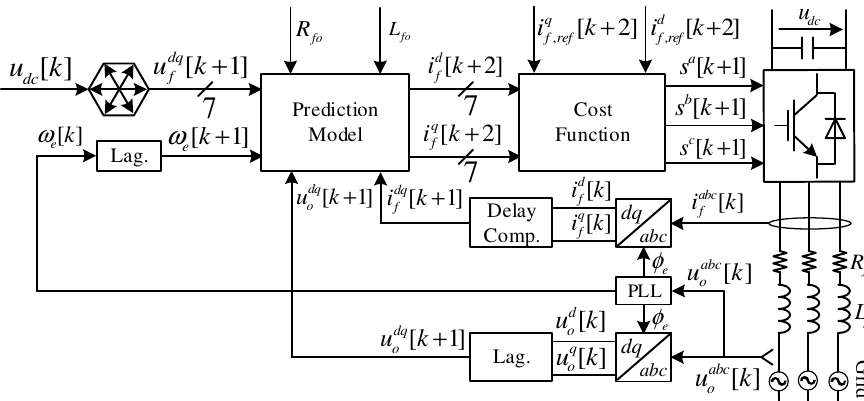
Figure 2. For a 2-level power converter: ( a ) real switching VVs, and ( b ) real and virtual switching VVs.